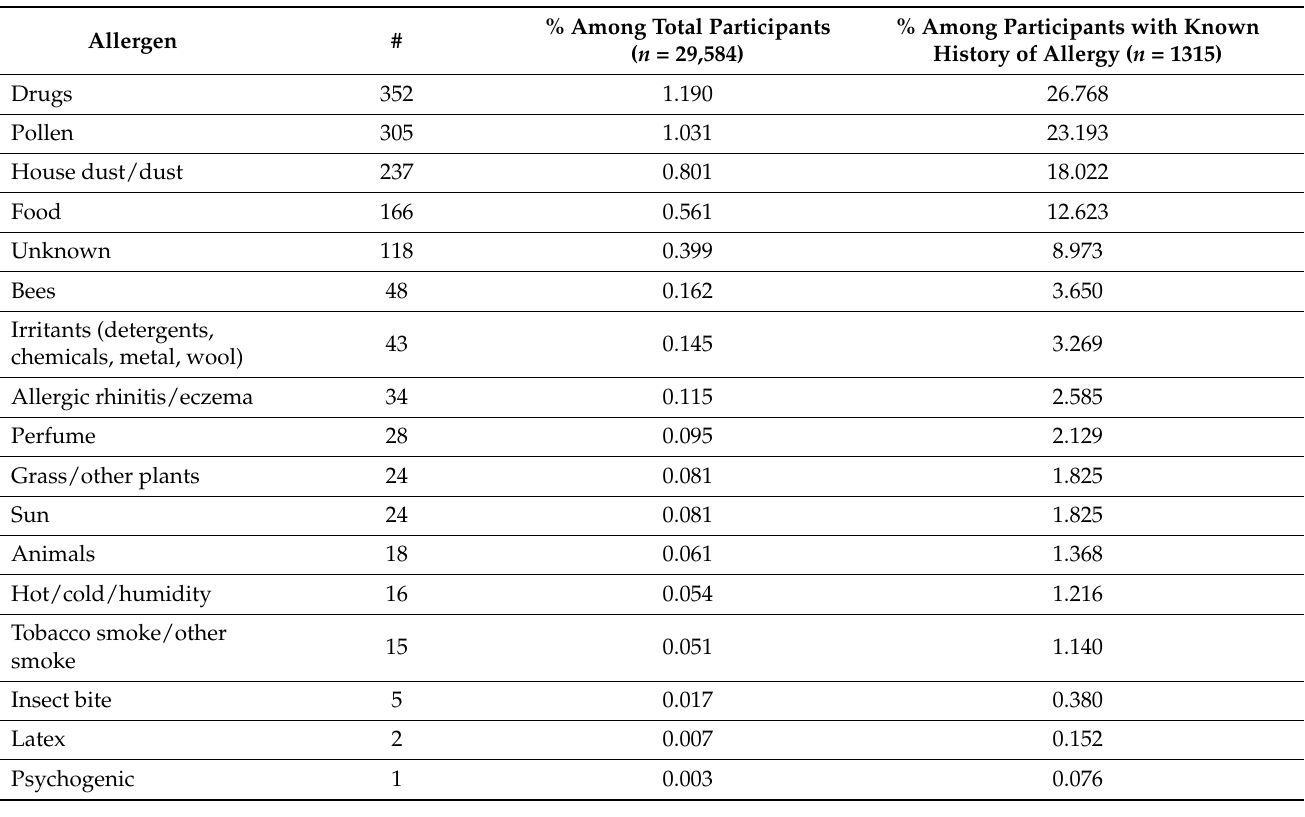
Table 4. Distribution of self-reported allergens/sources by the participants with known history of allergy.